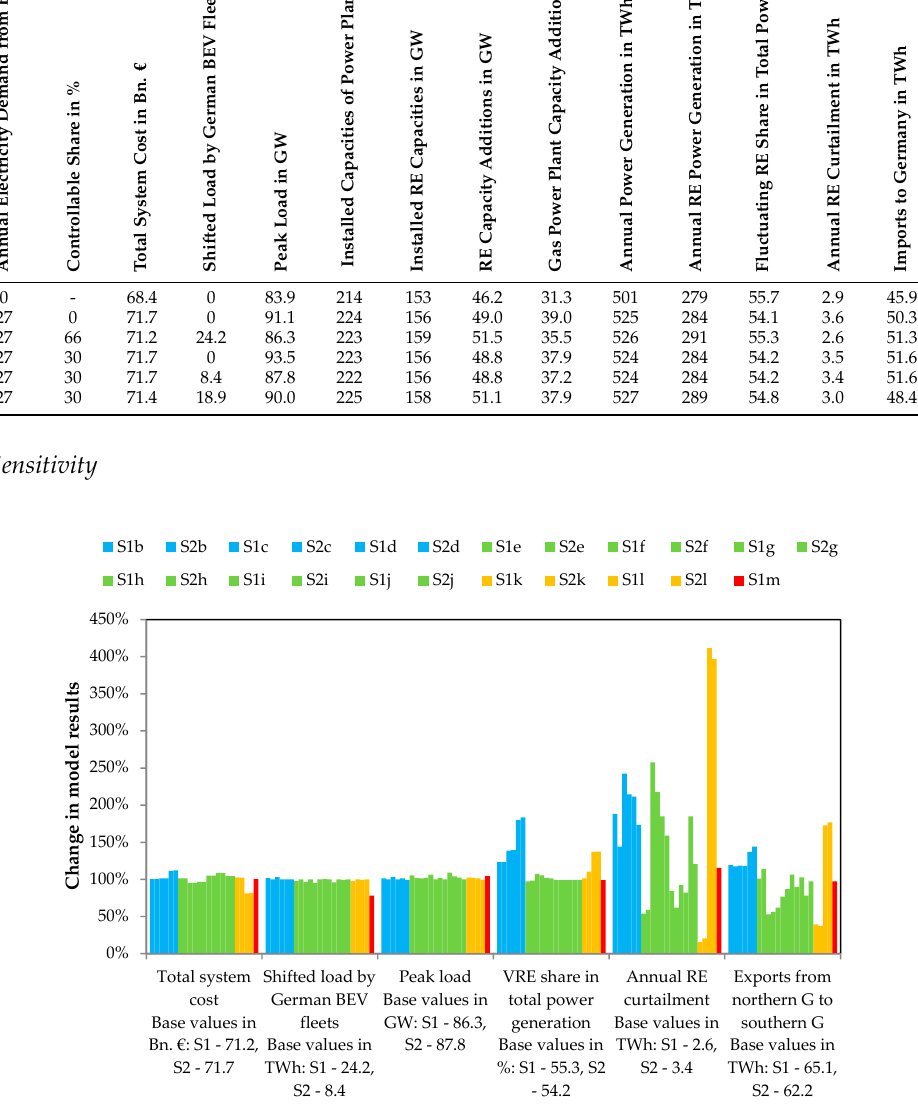
Energies 2020 , 13 , 1093 41 of 44 Table A11. Sensitivity scenario results of scenario S1m in comparison with all reference and baseline scenarios S0–S2. Total system costs are given for the complete system boundary while all other values are given for Germany.